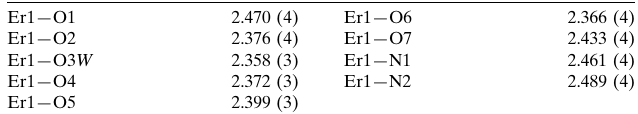
Selected bond lengths (A˚ ).